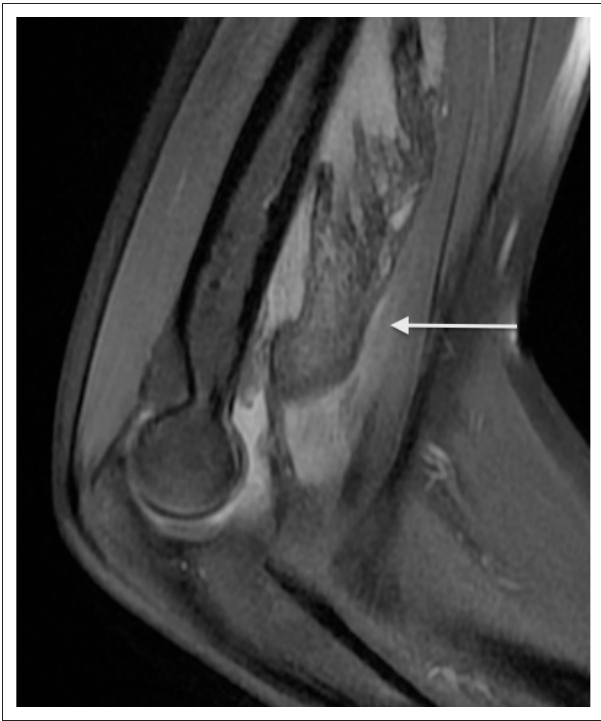
FIGURE 2: T1W sagittal image demonstrates a mass (arrow), within the right brachialis muscle, isointense to fat with a low–signal-intensity rim of lamellar